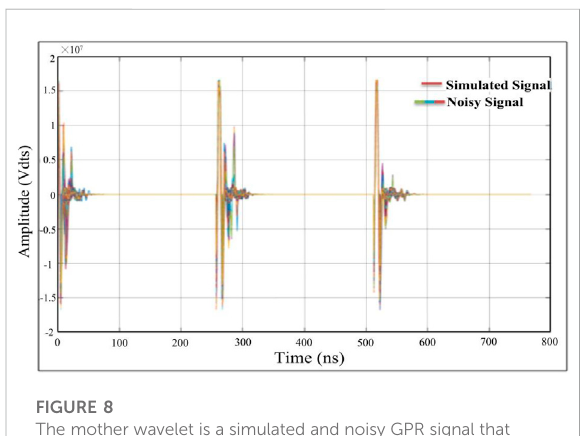
FIGURE 8 The mother wavelet is a simulated and noisy GPR signal that will be used for the CWT wavelet